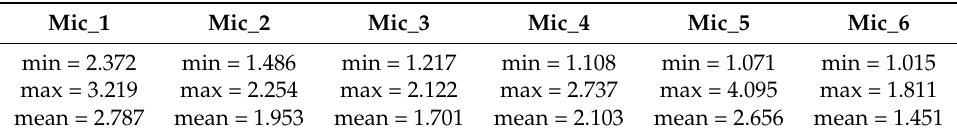
Table 1. A = V · G /1000 per Microphone in Area